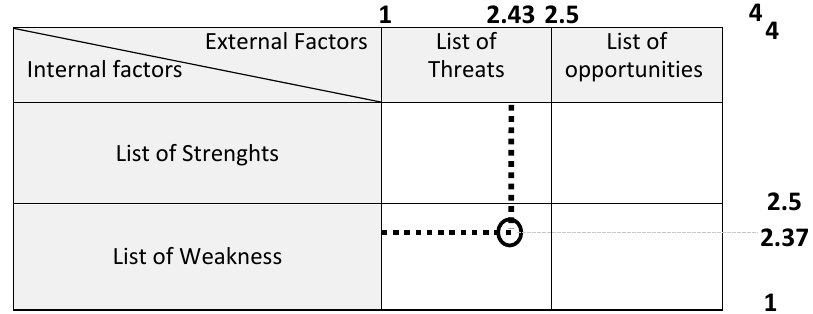
Fig. 8: Strategy characterization of Boujagh Wetland